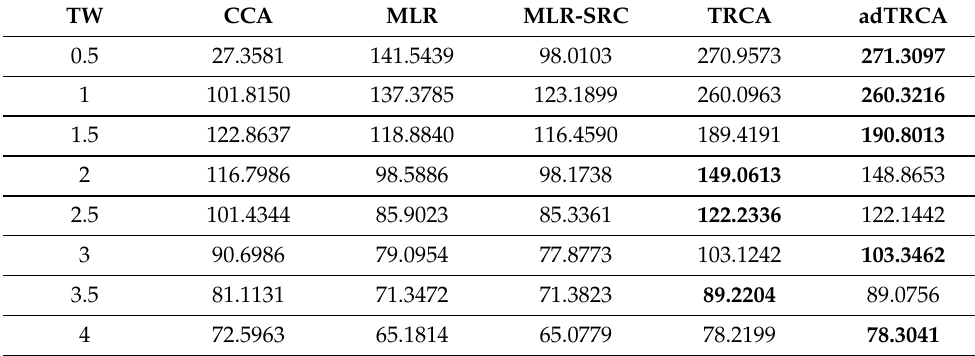
Figure 1. Average Classification over all subjects ( a ) for the Speller dataset and ( b ) the EPOC dataset 14 using the basic configuration with respect to the EEG channels. In both cases, the time window ranges from 0.5 s to 4 s (0.5 s interval). * indicates statistically significant difference between the TRCA and adTRCA methods, using paired sample t -test for Speller dataset and Wilcoxon signed rank test for the EPOC dataset ( p < 0.05). Table 2. ITR on Speller dataset—9 channels.